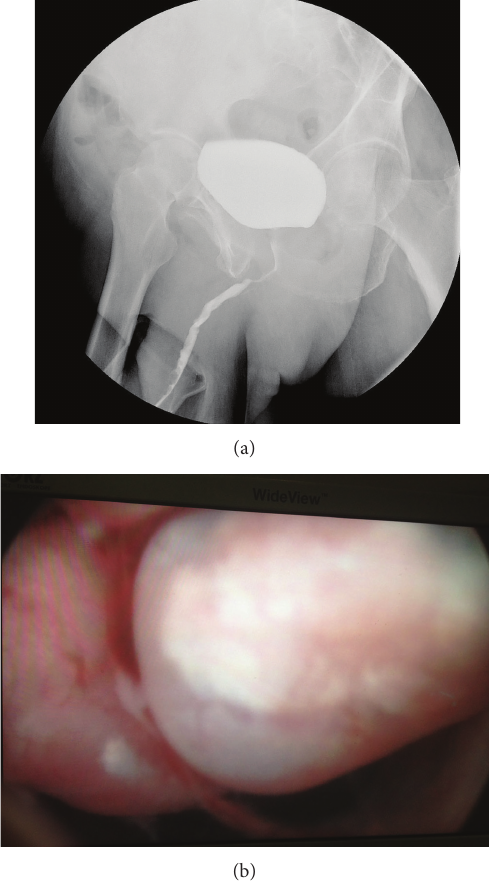
Figure 1: Diagnostic images. (a) Urethral stenosis. Voiding ure- thrography. (b) Nodular tumour appearance in penile urethra.